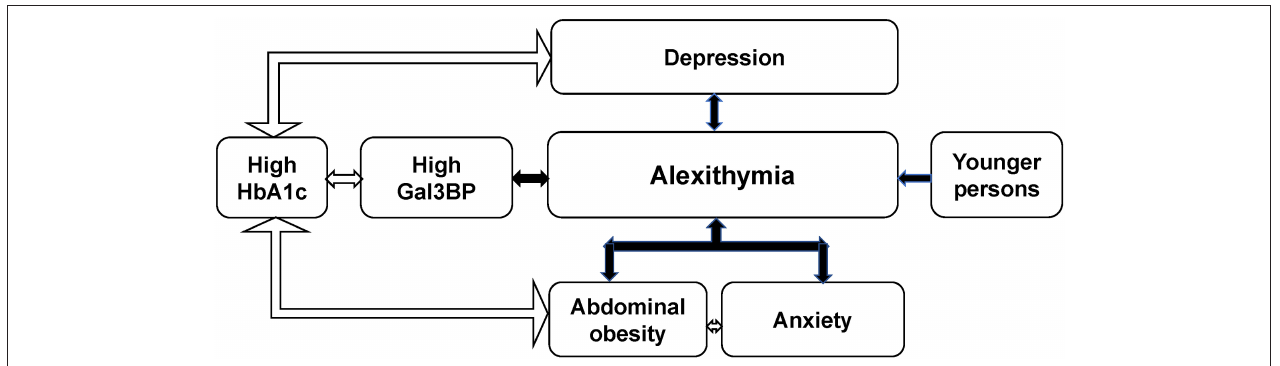
FIGURE 1 | Graphic illustration of the demonstrated significant